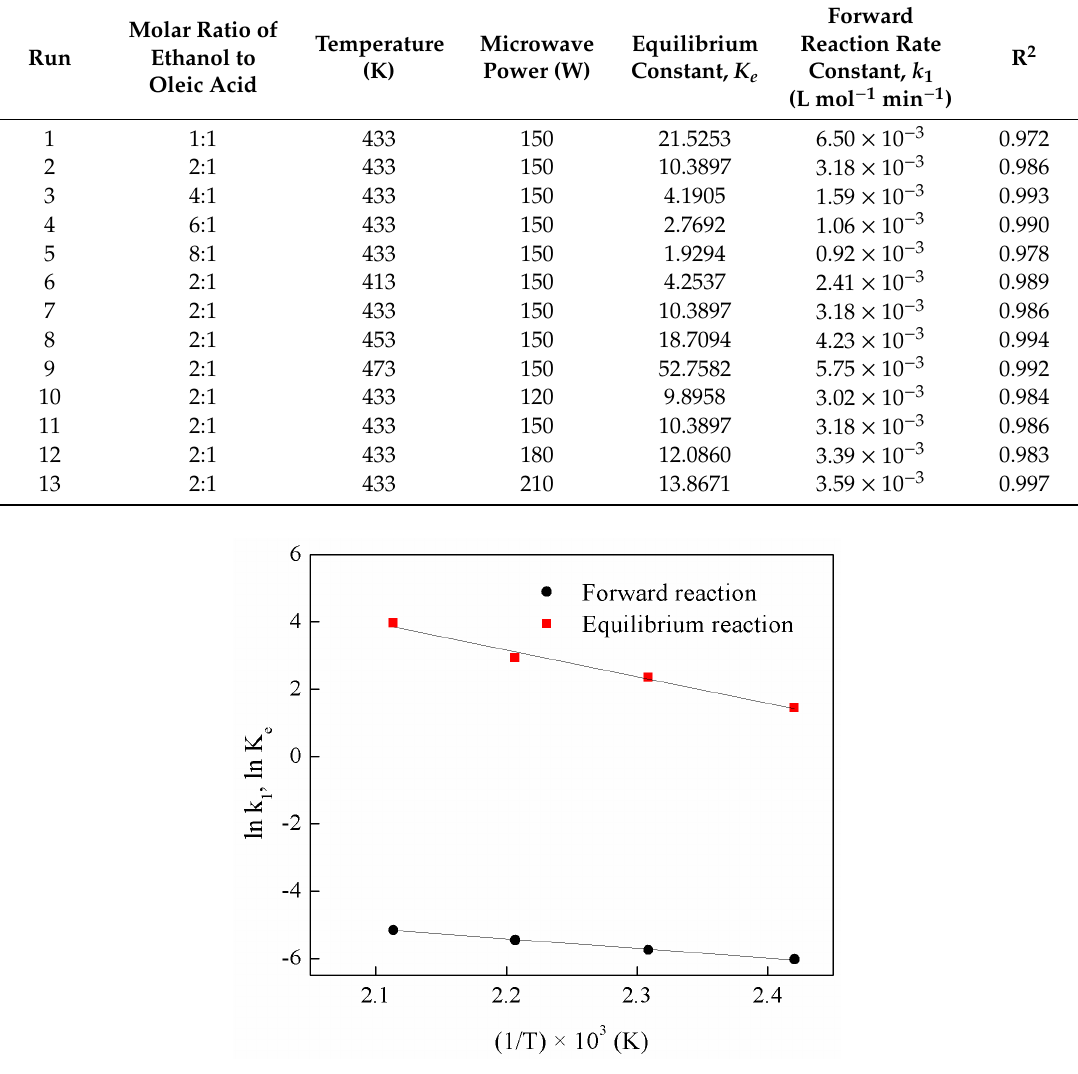
Figure 5. Arrhenius–Van’t Hoff plot for equilibrium rate constant and forward reaction rate constant of esterification reaction. Table 2. Activation energy, molar reaction heat, and pre-exponential factor for oleic acid esterification with ethanol using microwave